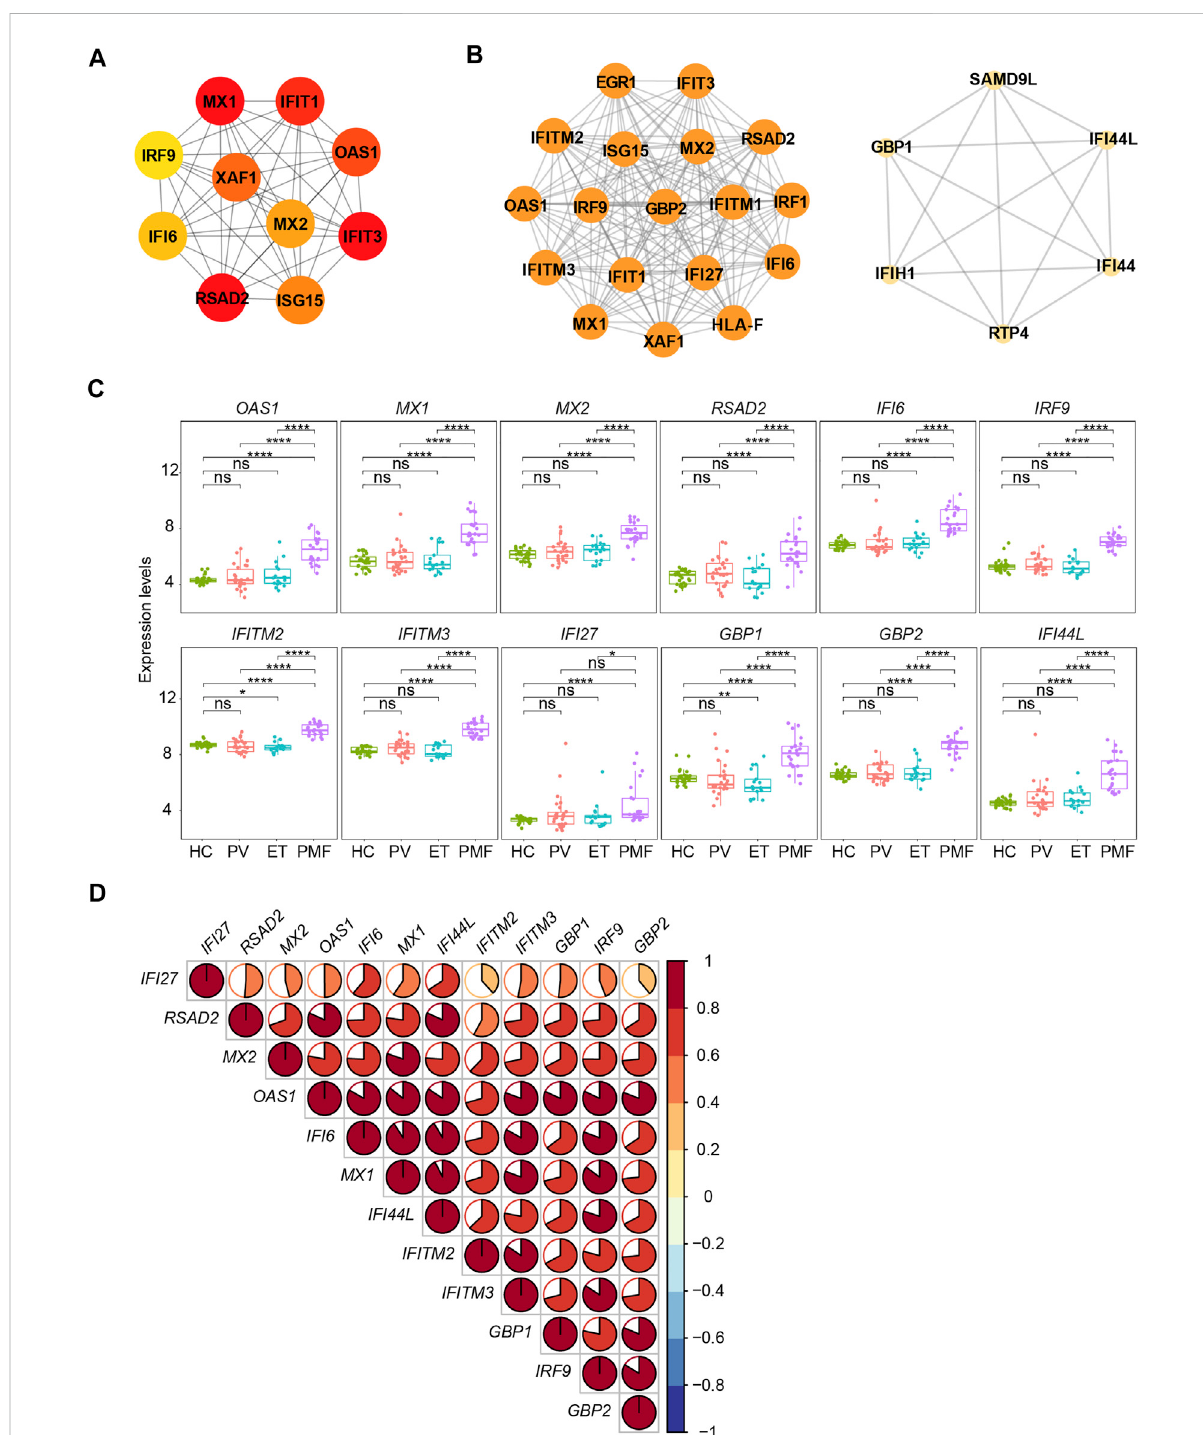
FIGURE 7 (A) Top 10 hub genes from the PPI network analysis for the upregulated genes uniquely in JAK2V617F + PMF. Nodes denote encoded proteins, and edges denote the interaction between two encoded proteins. The color represents the scores ranked by the MCC method. The deeper color denotes the more important genes having higher scores. (B) Top two signi fi cant modules from the PPI network analysis for the upregulated genes uniquely in JAK2V617F + PMF. The color and size represent the degrees of the nodes. The bigger size and deeper color denote the more important genes having higher degrees. (C) Expression levels of the key genes uniquely upregulated in JAK2V617F + PMF. (D) Correlation of the expression levels of genes in (C)